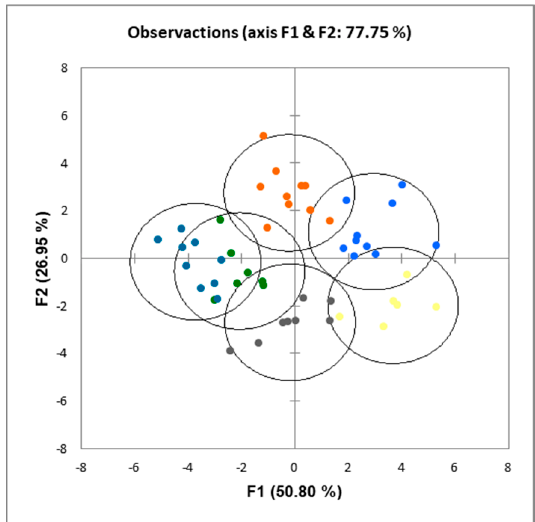
Figure 3. Discriminant analysis of liver fatty acid composition of rats fed CAS (yellow); CAS-OB (grey); KEM (orange); KEM-OB (dark blue); PEM (light blue); PEM-OB (green). For details on the diets, see the Materials and Methods section and Table 2. All groups were different ( p < 0.001) from each other.